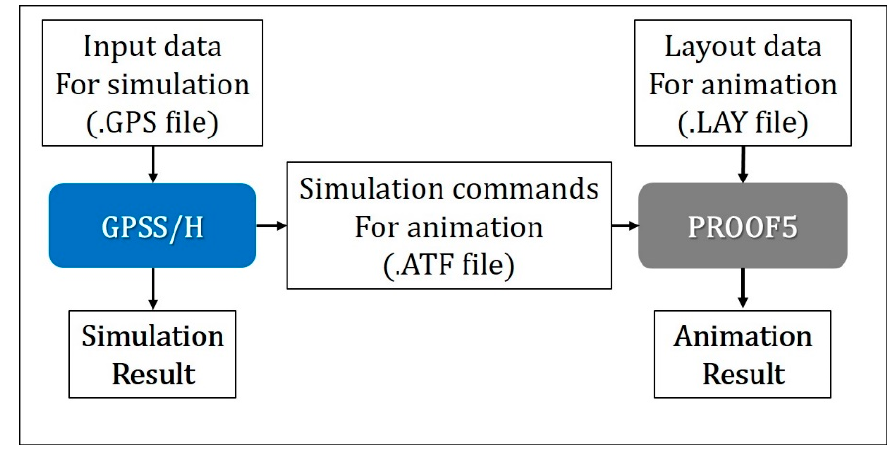
Figure 5. Method of integrating general-purpose simulation system/H (GPSS/H) simulation with PROOF5 animation.